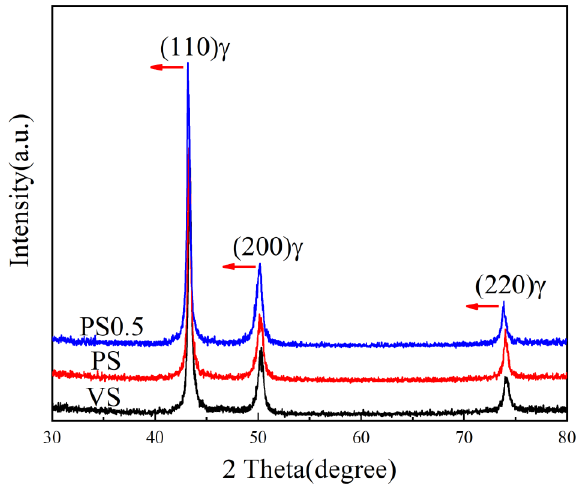
Figure 2. The XRD patterns of the sintered alloys.